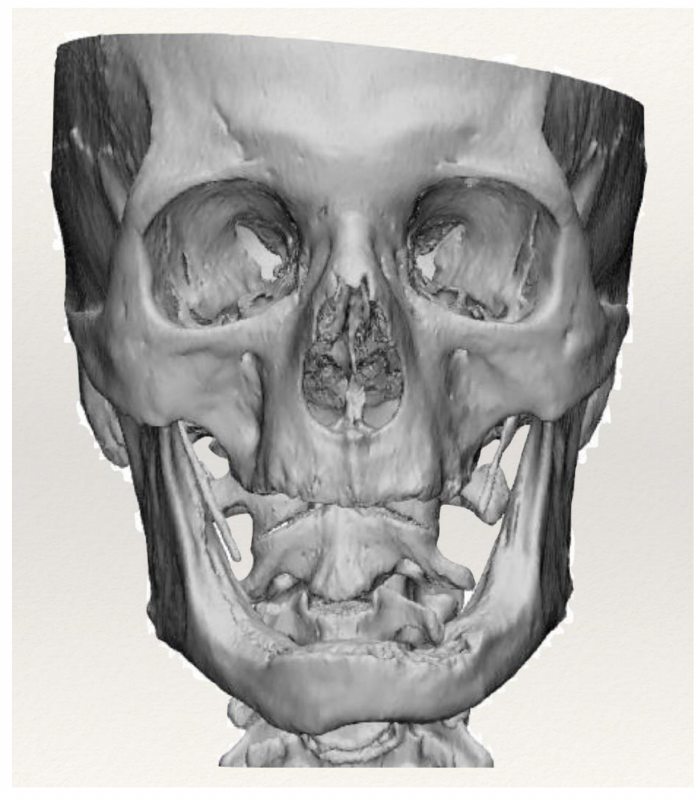
Figure 1. 3D model of the patient.